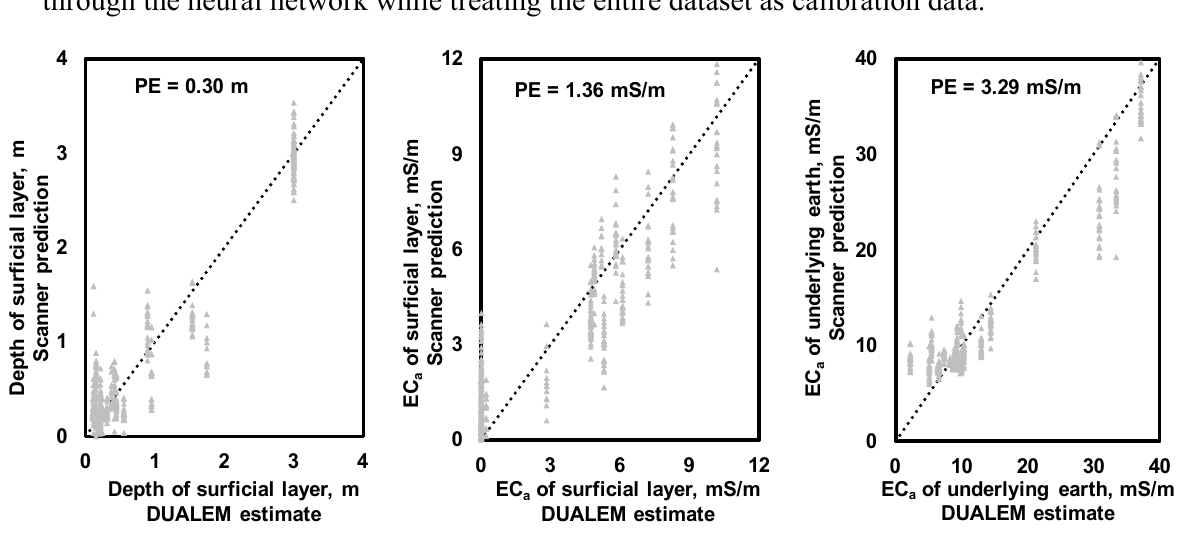
Figure 8. Relationships between the soil profile model parameters estimated using DUALEM-21S and those predicted using the scanner system measurements processed through the neural network while treating the entire dataset as calibration data.